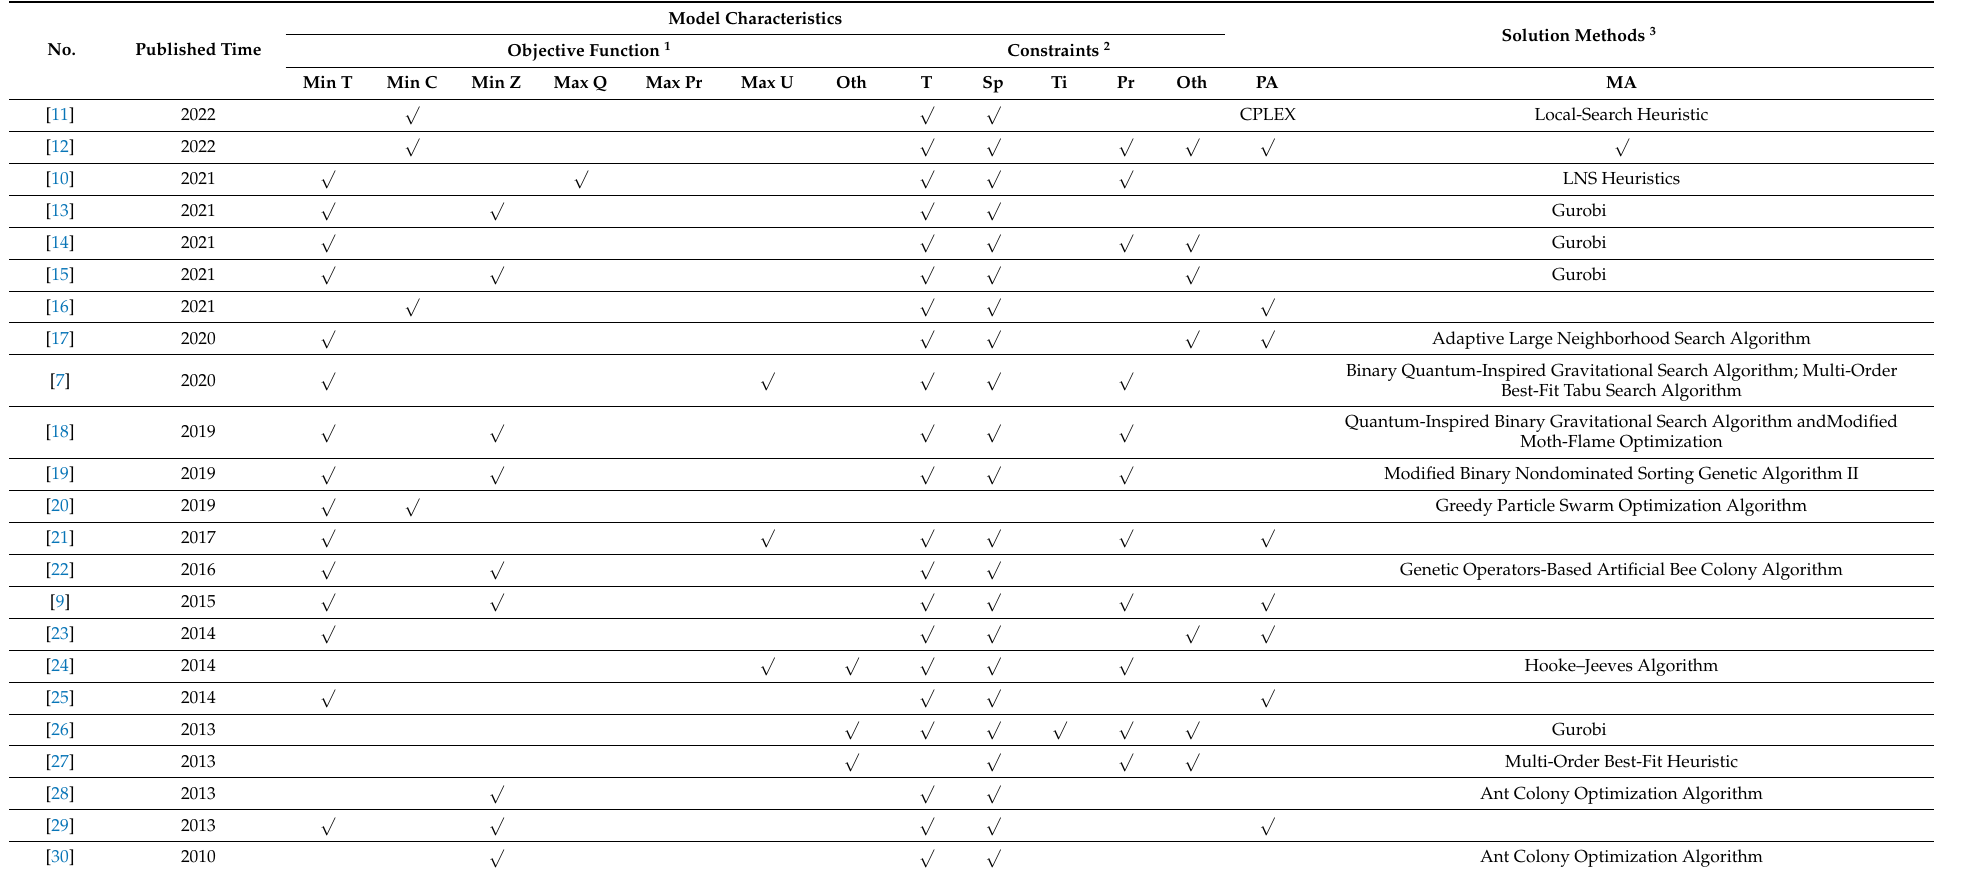
Table 3. Overview of research on ship lock scheduling problems.